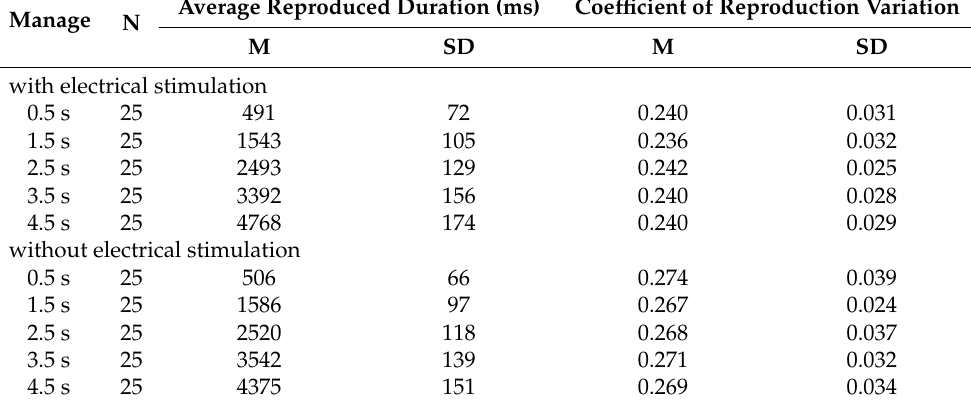
Table 2. Average reproduced duration and coefficient of reproduction variation were measured in 5 target durations repeated with and without electrical stimulation. Average Reproduced Duration Manage N